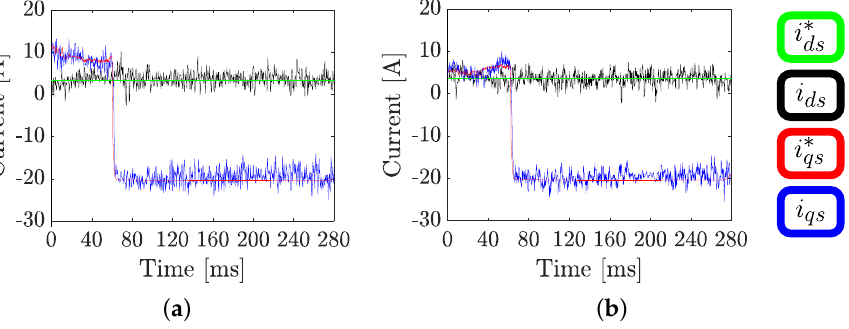
Figure 11. Transient response in q -axis of stator current for a rotor speed change from 200 (rpm) to − 200 (rpm) at 2.5 (kHz) of sampling frequency: ( a ) VV4; ( b )